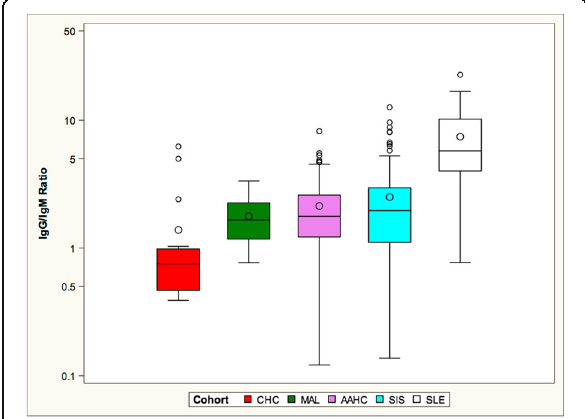
Fig. 3 SLE had the highest mean IgG/IgM anti-DNA antibody ratio. The mean ratios of the SIS, AAHC, and MAL cohorts did not significantly differ from each other. The mean ratio for the CHC cohort was significantly lower than all other groups